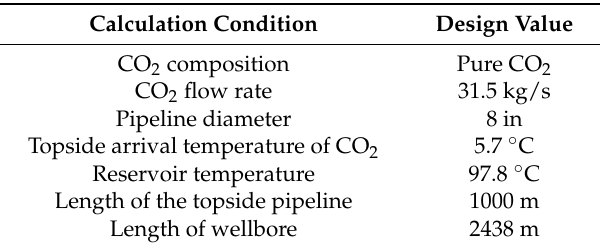
Table 1. Calculation conditions for the numerical simulation.